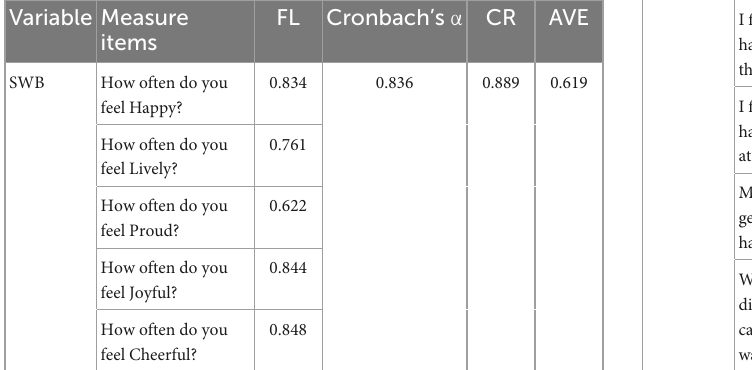
TABLE 2 Reliability and validity of the measurement scale of